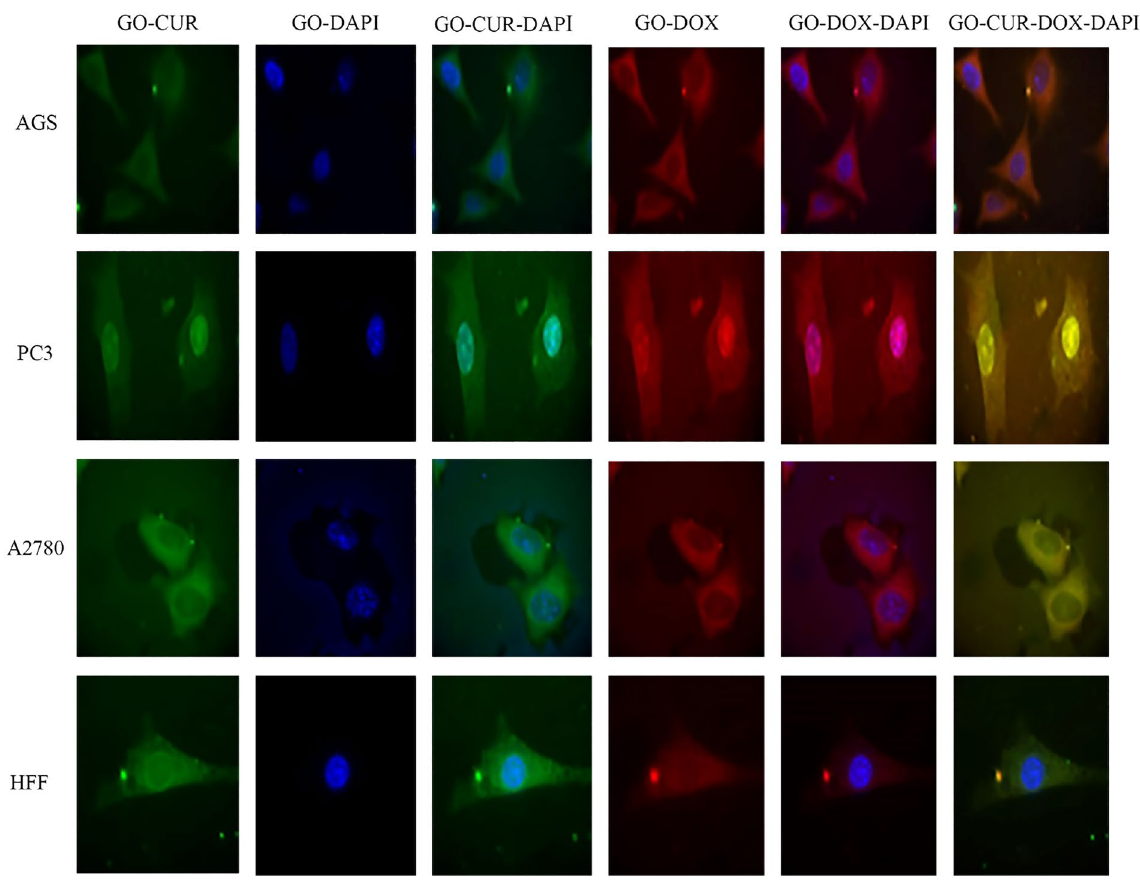
Figure 9. Cellular uptake images of AGS, PC3, A2780 and HFF cells incubated with GO CUR-DOX for 180